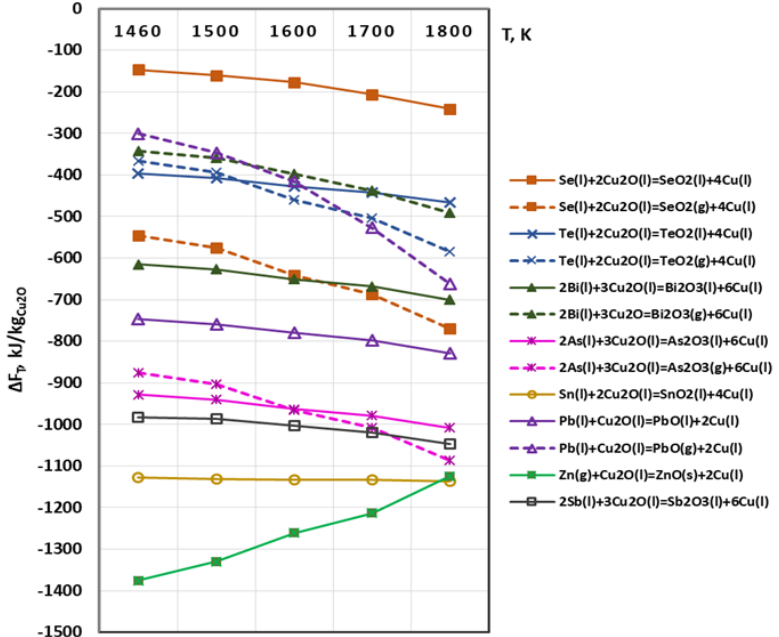
Figure 4. Free energy for interaction between Cu 2 O and metals impurities in vacuum.